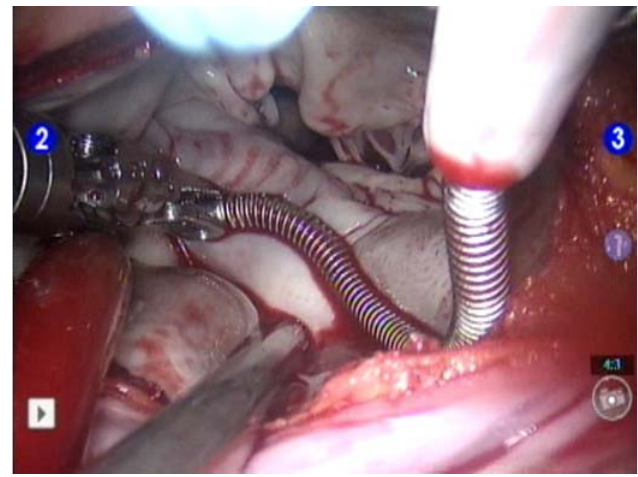
Figure 5. Maze lesion forming inferior portion of pulmonary vein isolation box.